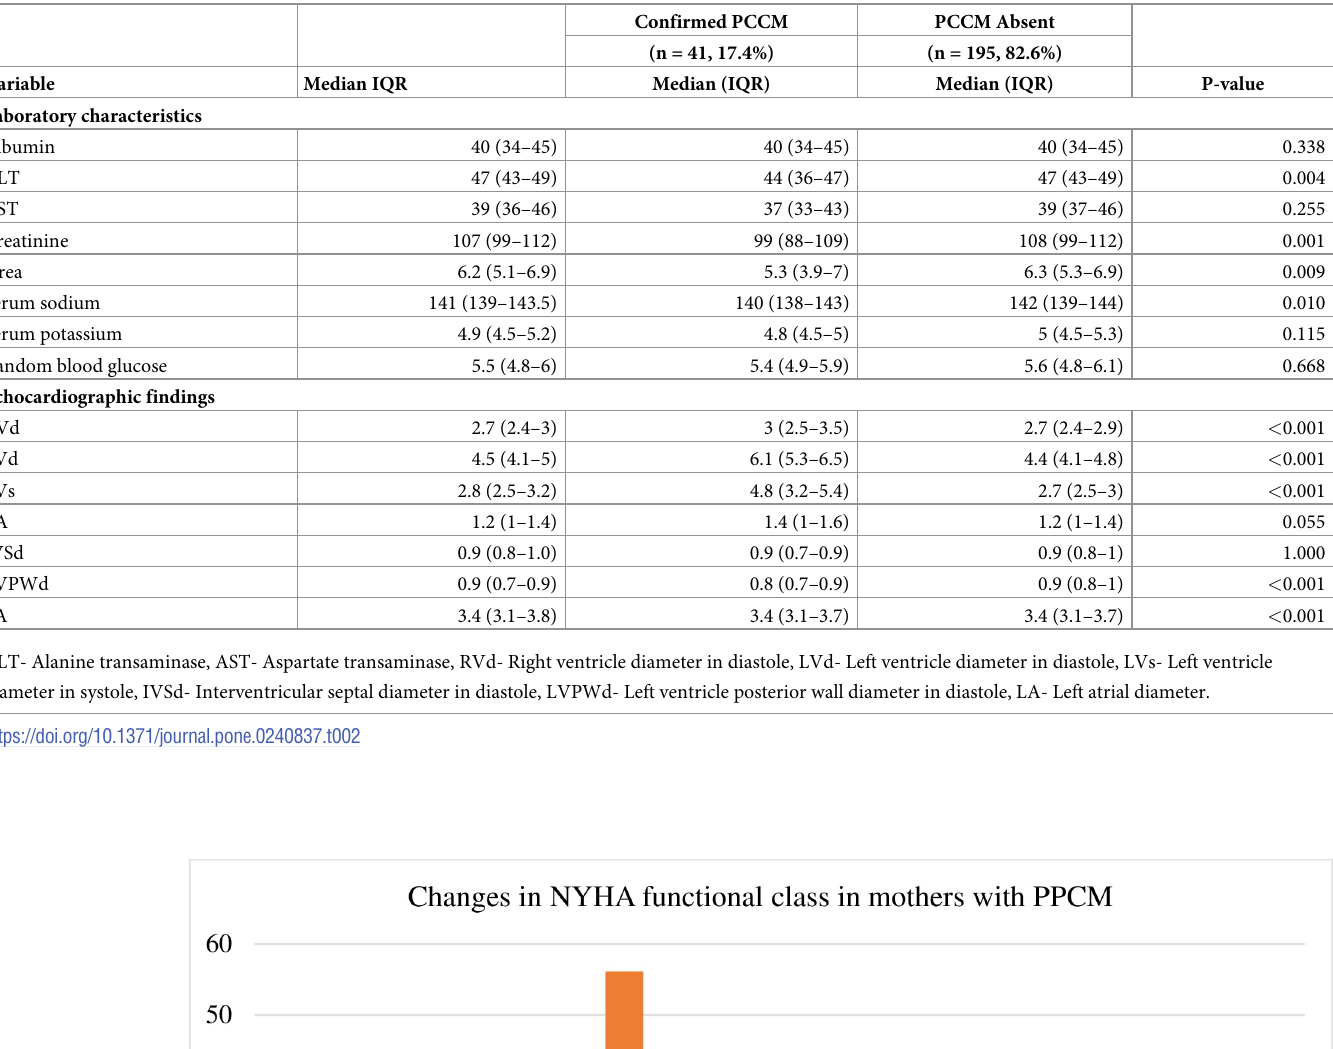
Table 2. Laboratory and echocardiographic characteristics of the study participants.